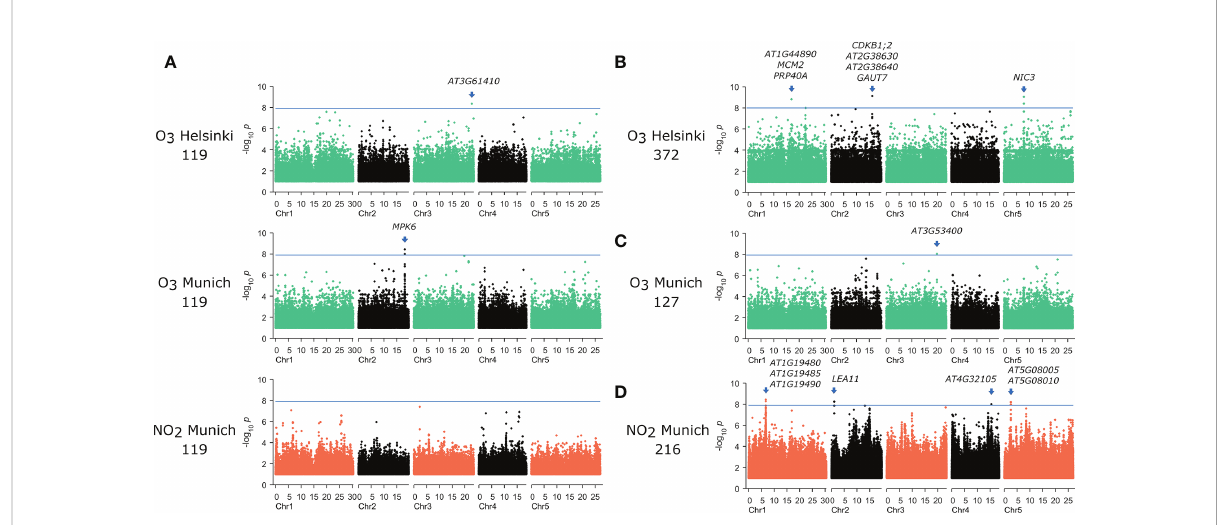
FIGURE 4 Manhattan plots of GWAS results. Results (A) from accelerated mixed model (AMM) analysis with the common set of 119 accessions in the three different experiments, (B) with 372 accessions treated with O 3 in Helsinki, (C) 127 accessions treated with O 3 in Munich and (D) results from non-parametric Kruskall-Wallis tests (KW) of 216 accessions treated with NO 2 . The horizontal line corresponds to Bonferroni corrected P < 0.05 signi fi cance threshold. Genes with signi fi cant SNPs are marked with an arrow. The SNPs are plotted according to their physical order in the chromosomes. The Mb distance is marked in below each